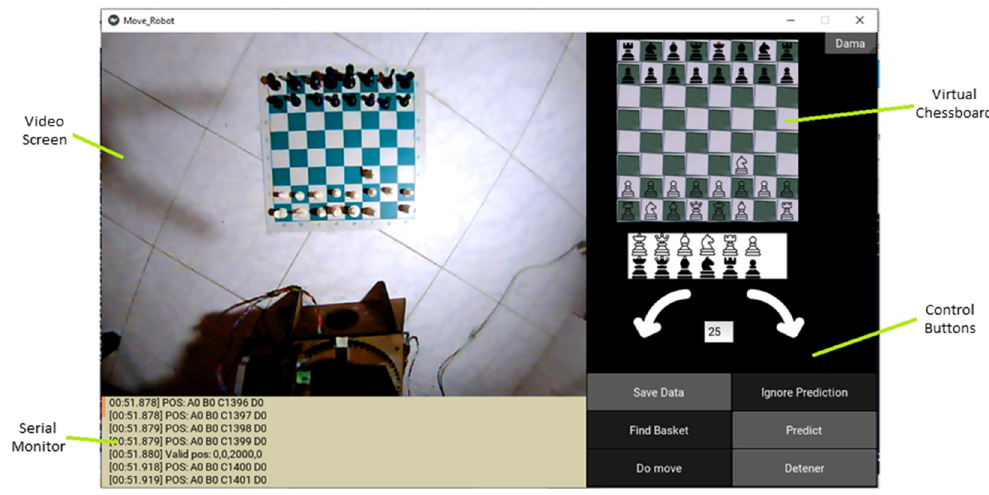
Figure 14. Graphical user interface.